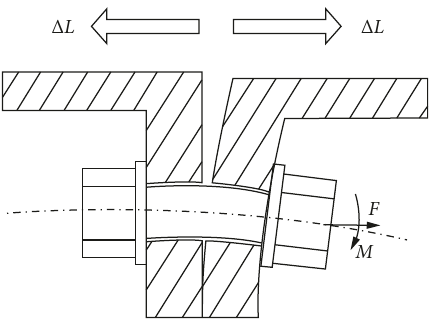
Figure 11: The sketch of the inner force in the